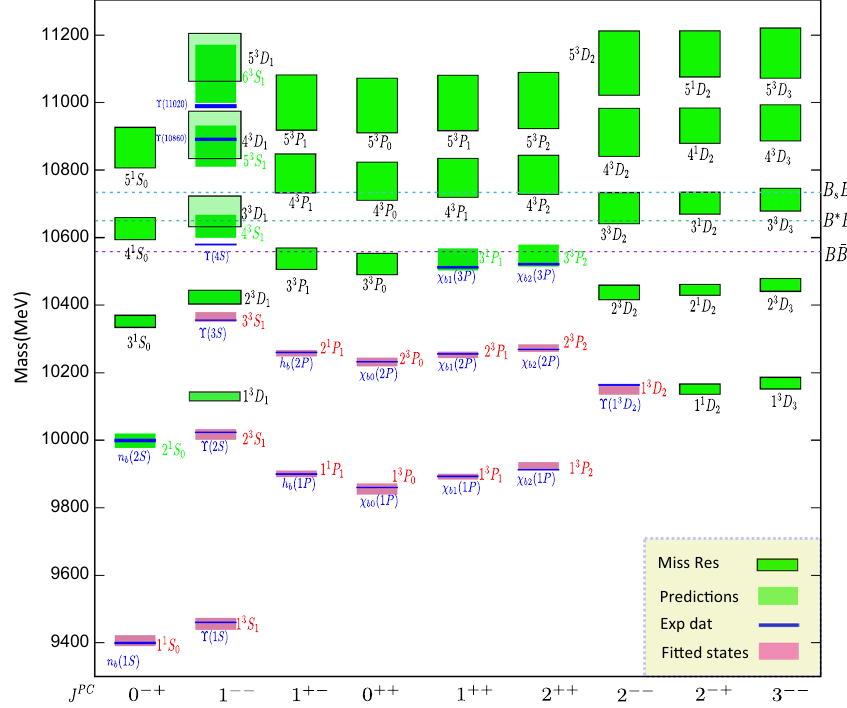
Fig. 2 Bottomonium spectrum computed with potential II. Same conventions as in Fig. 1